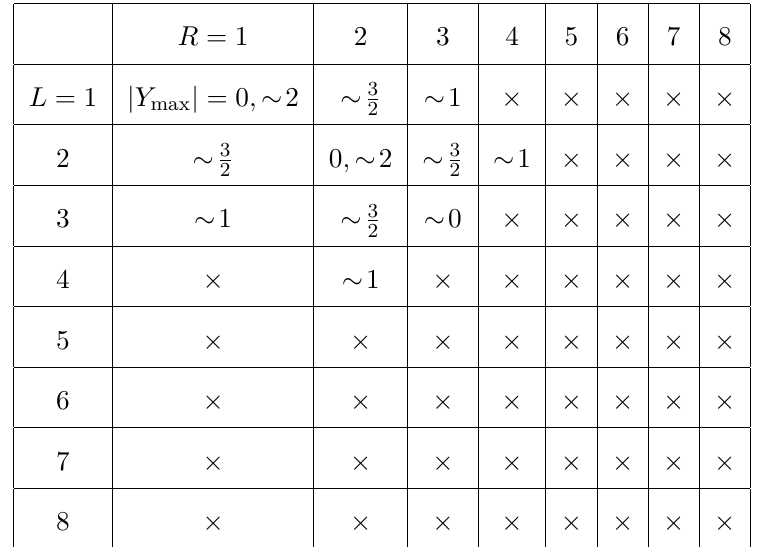
. A ∼ means the representation requires flipping the γ